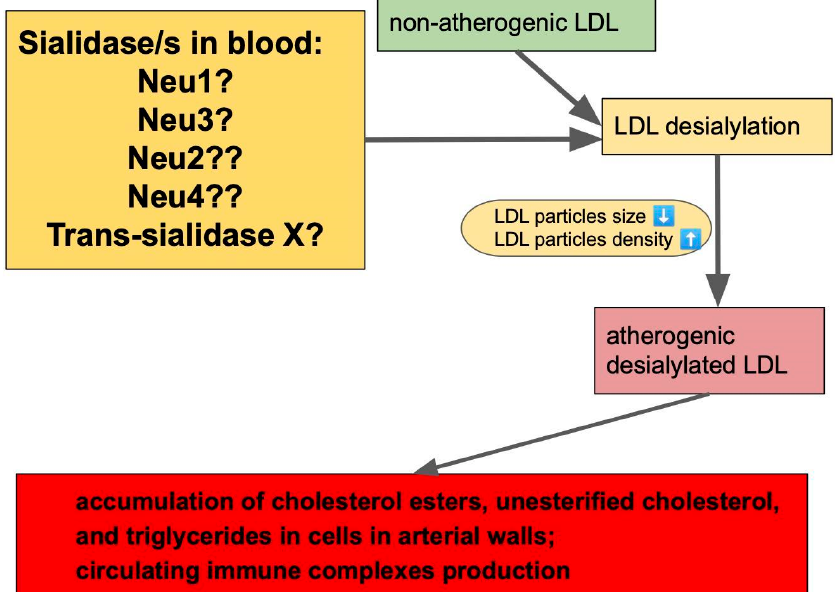
Figure 2. Potential contributors to sialidase activity in blood are neuraminidases (Neu1–4) and yet to be identified trans-sialidase. One of these enzymes (or a combination) leads to desialylation of normal LDLs, giving them atherogenic properties. “?” sign at neuraminidases means that it is not known exactly which one/s contributes to sialidase activity in blood. Arrows between boxes represent a sequence of events leading to atherogenic changes starting from enzymatic activities leading to the elimination of sialic acid residues from LDLs. Deasialilation of LDL also leads to a reduction in particle’s size, and increase in particle’s density.